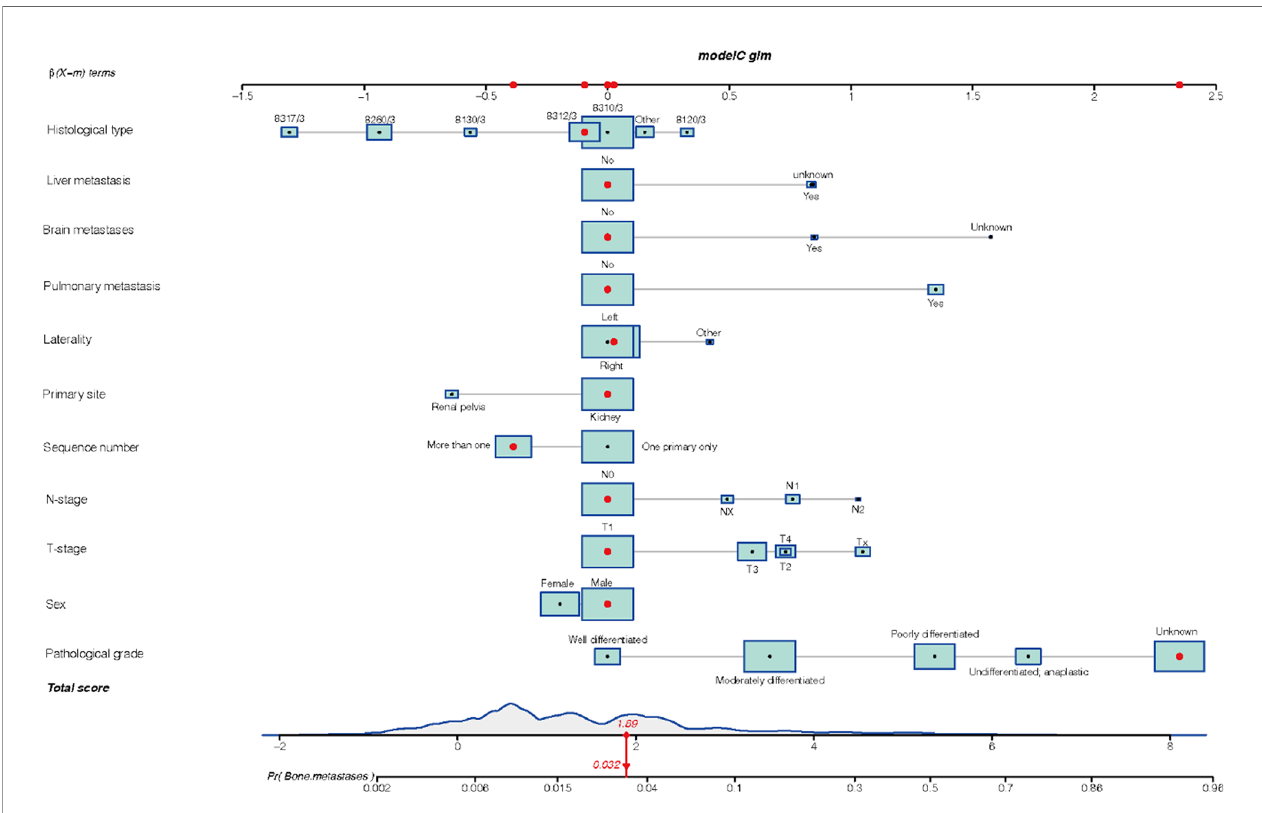
FIGURE 1 | The nomogram model of bone metastasis in patients with kidney cancer: 8317/3 represents chromophobe renal cell carcinoma, 8260/3 represents papillary adenocarcinoma, 8130/3 represents papillary transitional cell carcinoma, 8312/3 represents renal cell carcinoma, 8310/3 represents clear cell adenocarcinoma, 8120/3 represents transitional cell carcinoma, and other represents the number of patients is less than 1,000.